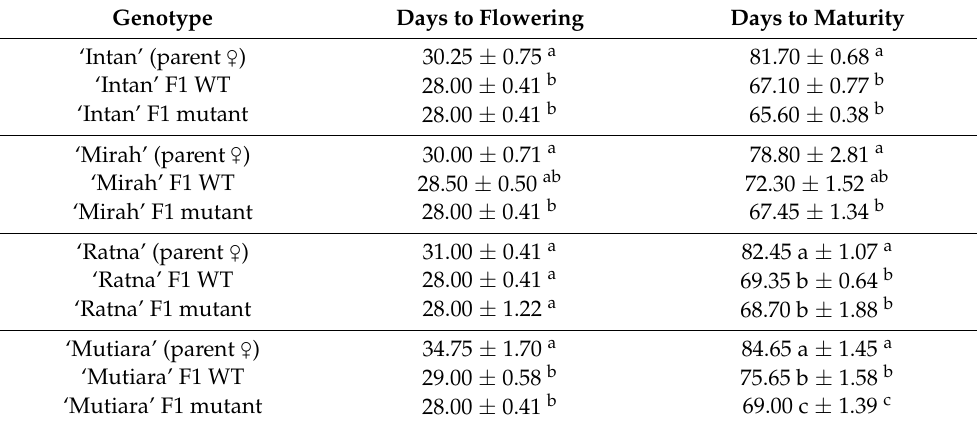
Table 2. Days to flowering and days to maturity of F1 generation in four tropical tomato genetic